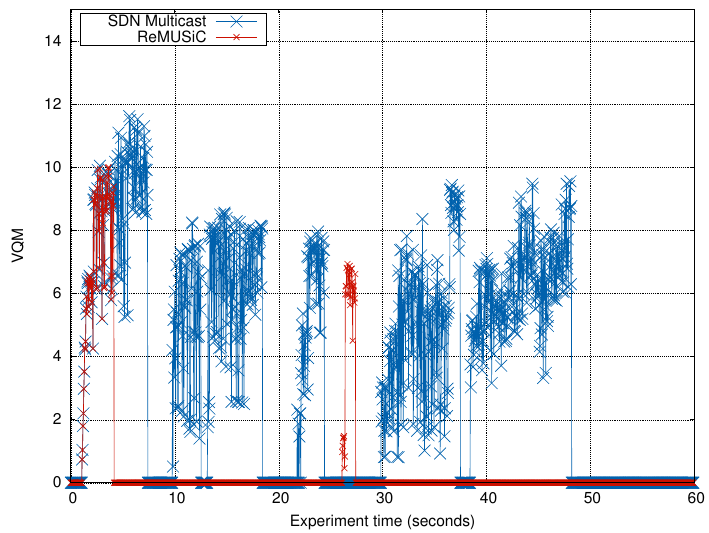
Figure 16. VQM impact in both ReMUSiC and SDN Multicast